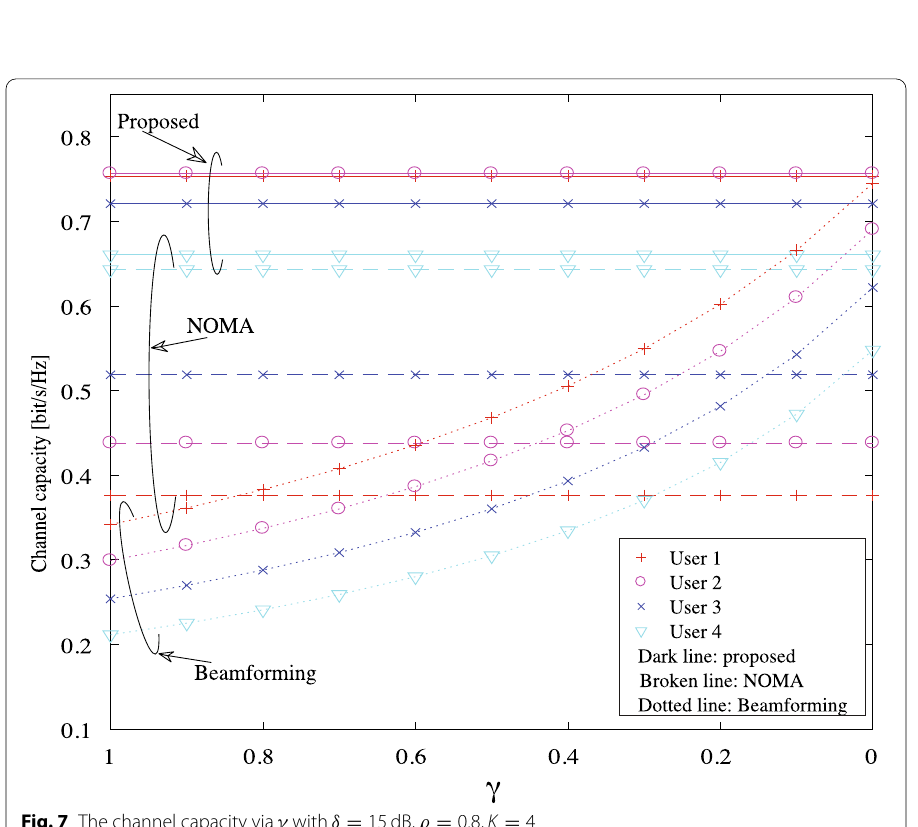
Fig. 7 The channel capacity via γ with δ = 15dB , ρ = 0.8 , K =